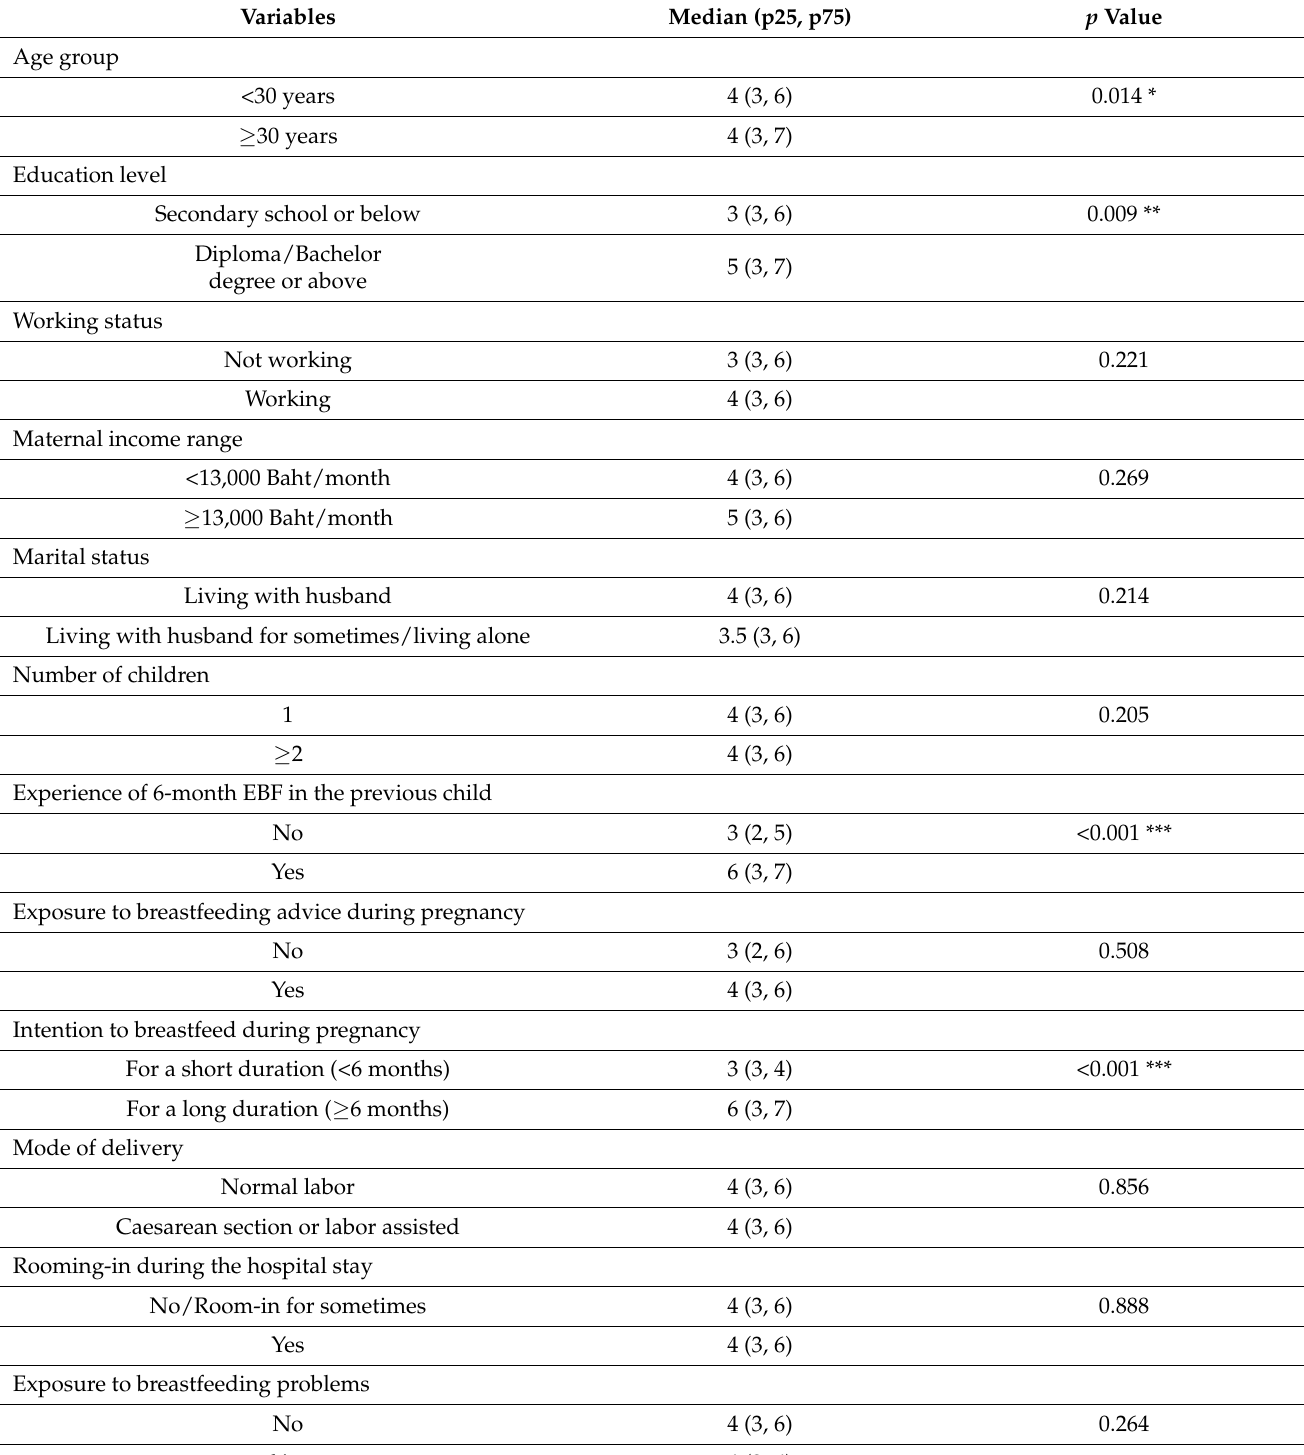
Table 2. Period of exclusive breastfeeding (EBF) survival by personal attributes (log